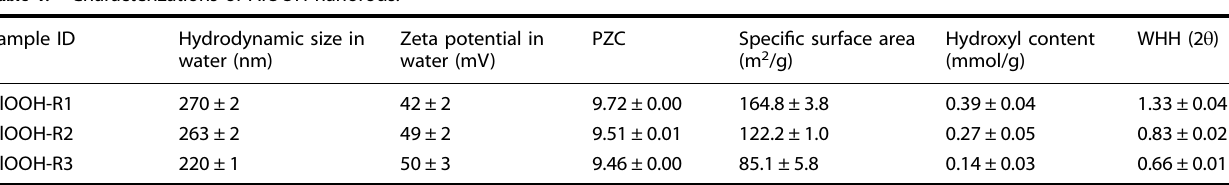
Fig. 1 Characterization of engineered AlOOH nanorods. A TEM images of AlOOH nanorods synthesized at a temperature of 160 °C (R1), 180 °C (R2), and 200 °C (R3). The scale bar is 100 nm. B XRD analysis of engineered AlOOH nanorods. C FTIR spectra of AlOOH nanorods. D The surface hydroxyl contents of AlOOH nanorods. Table 1. Characterizations of AlOOH